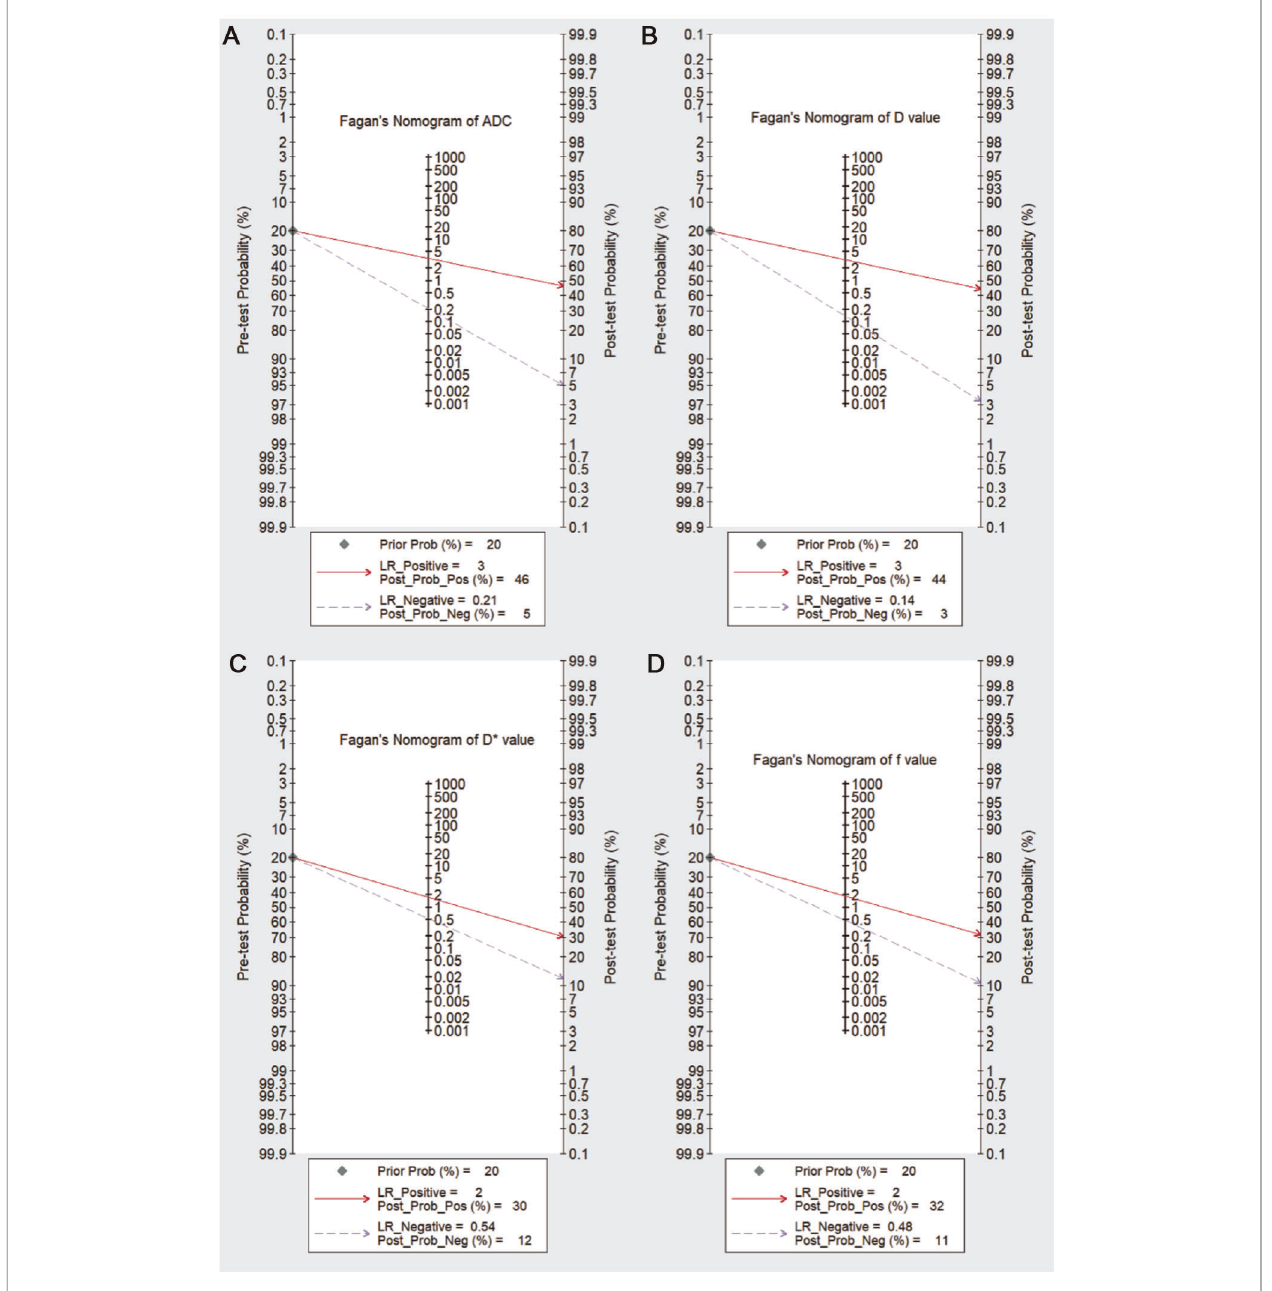
FIGURE 10 | Fagan ’ s nomogram of the ( A ) apparent diffusion coef fi cient (ADC value); ( B ) tissue diffusivity ( D value); ( C ) pseudo-diffusivity ( D * value); and ( D ) perfusion fraction ( f